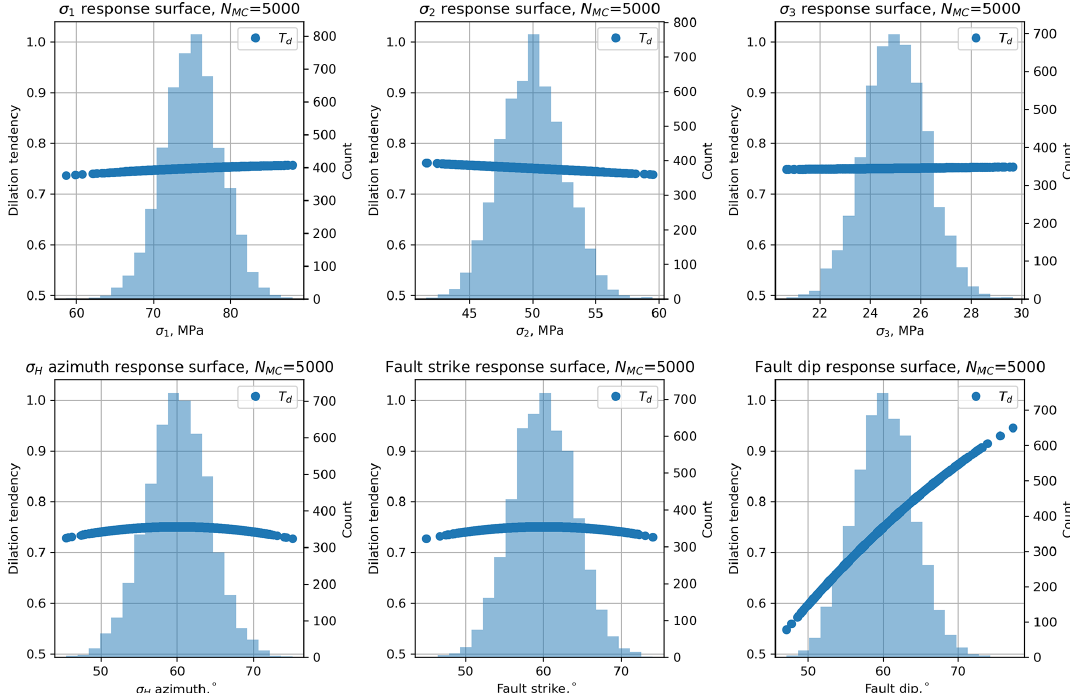
Figure A1. Histograms of input variables used to calculate dilation tendency ( T d ) for the synthetic distributions shown in Table 2.